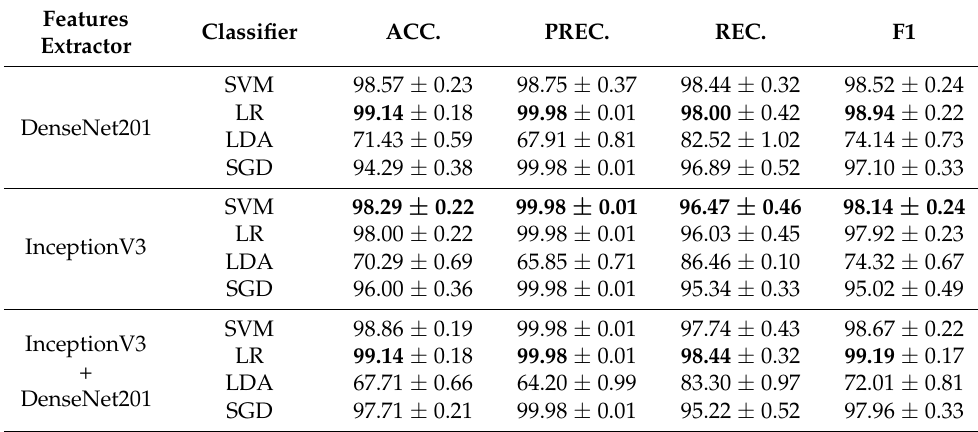
Table 5. Performance of the classifiers on different type of